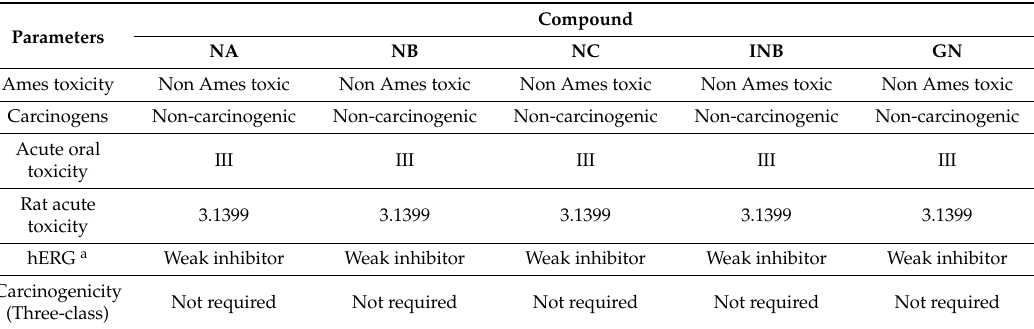
Table 4. Toxicological properties of the compounds.